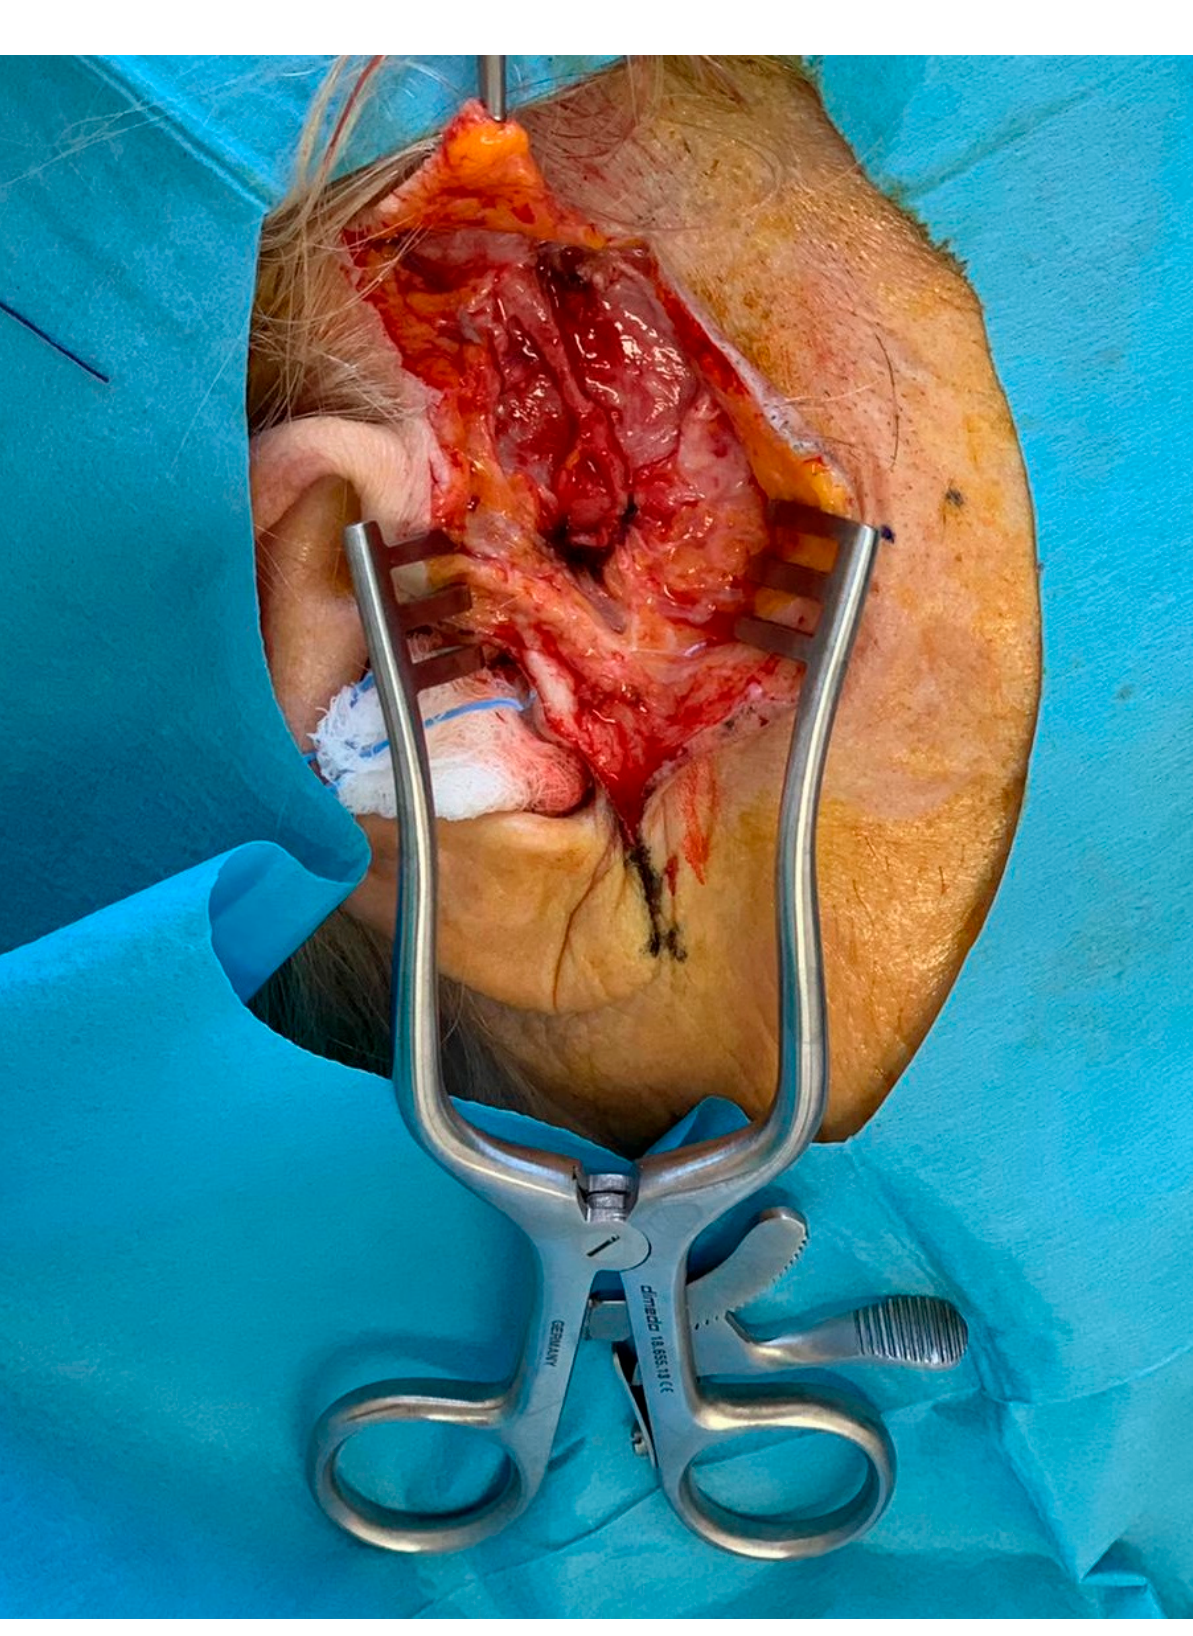
Figure 2. Intraoperative view of the dissected temporal artery. Collateral and adjacent vessels are ligated and cut until an adequate length of the specimen is reached, then the artery can be harvested and measured with a sterile